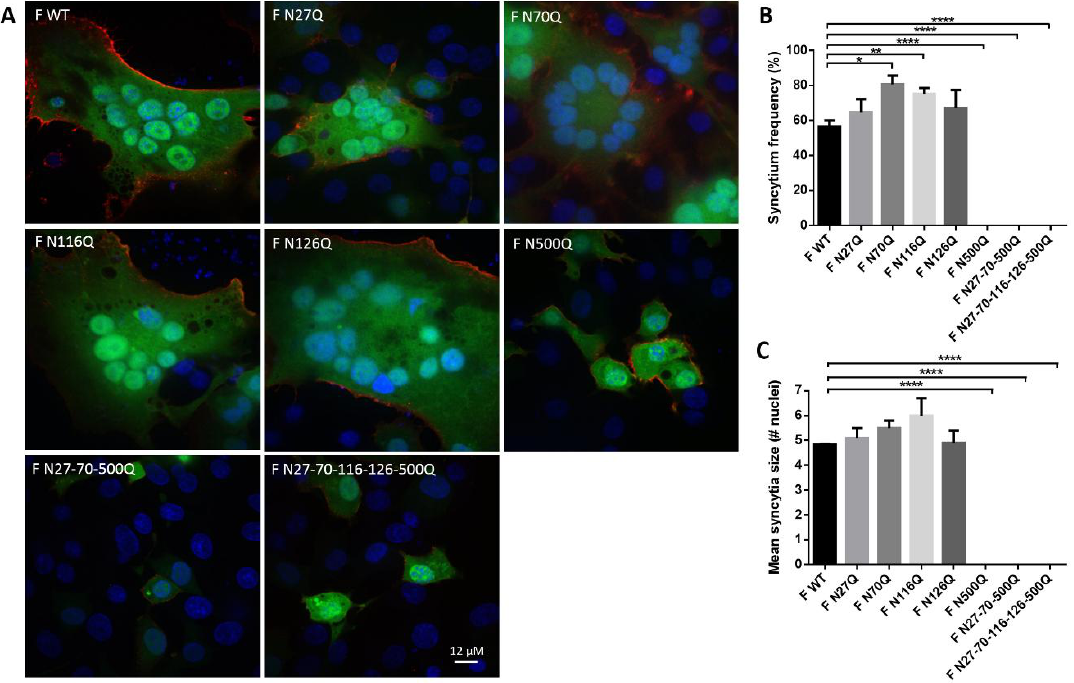
Figure 4. The effect of loss of RSV F N-glycosylation sites on syncytia formation. After 24 h incubation of BSR T7/5 cells transfected with glycomutant RSV F plasmids, the cells were fixed and permeabilized. RSV F proteins were stained with palivizumab and secondary goat anti-human IgG AF488. Syncytia were visualized by staining the nuclei with DAPI and further analysed by fluorescence microscopy. ( A ) Representative confocal images of the syncytia are shown for each glycomutant RSV F protein, scale bar = 12 µM. ( B ) Syncytia frequency and ( C ) syncytium size of 100 transfected cells was counted. Data represents the mean (±SD) of three independent repeats. * p < 0.05; ** p < 0.01; **** p < 0.0001 (Student’s unpaired two-tailed t test).